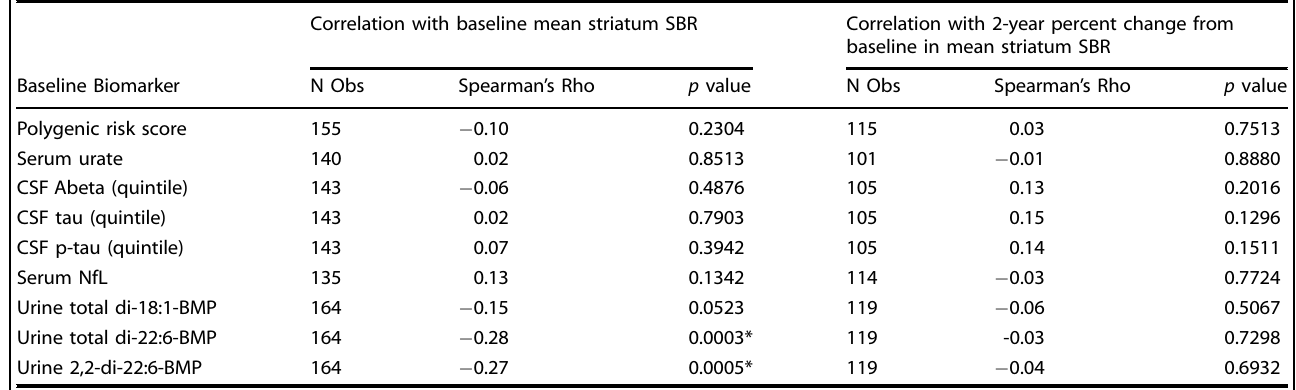
Table 5. Correlations between baseline biomarkers vs baseline and longitudinal change in DAT speci fi c binding ratios among LRRK2 G2019S carriers. Correlation with baseline mean striatum